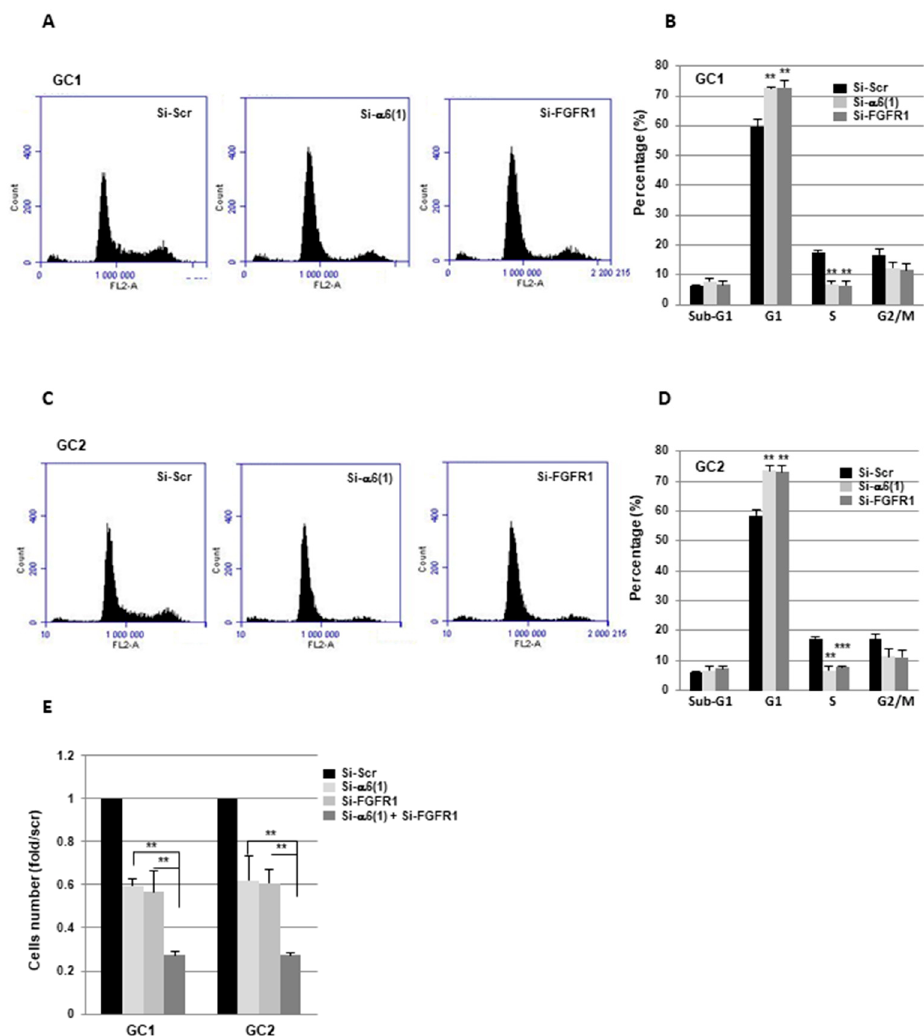
Figure 4. Cell cycle analysis and proliferation. ( A – E ) GBMSC derived from GBM biopsy specimens (GC1, GC2) were transfected with an α 6-integrin siRNA (si- α 6 (1)), a FGFR1 siRNA (si-FGFR1), a combination of both siRNA (si- α 6 (1) + si-FGFR1), or a scramble control (si-Scr). Propidium iodide staining was performed as described in section “Materials and Methods”, and the DNA content was analyzed using flow cytometry. The % of cells in sub-G1, G1, S and G2/M phases were quantified by the BD Accuri C6 software. ( E ) Cells number was measured by using the cell counter Countess II FL. Quantifications of 3 independent experiments are presented as means ± SD. *** p < 0.001; ** 0.001 < p < 0.01.